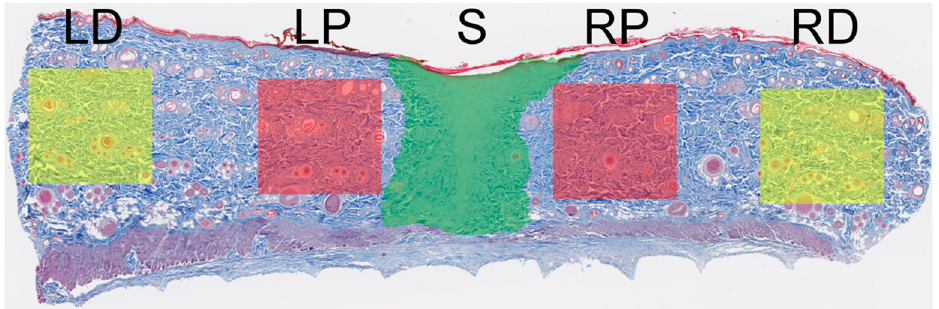
Figure 11. Diagram represents regions selected for automated collagen fiber analysis in MT-stained samples. Five areas were chosen, scar and four boxes 500 × 500 pixels of proximal and distant to scar area. S—scar zone, LD—left distant area, LP—left proximal area, RD—right distant area, RP—right proximal area.